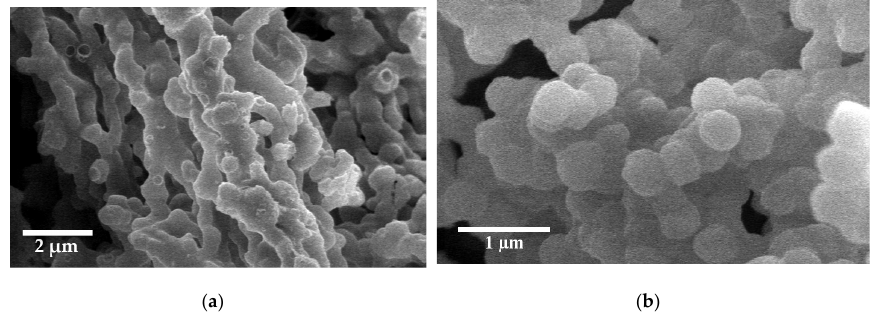
Figure 5. Scanning electron microscopy micrographs of: ( a ) E-SBA-S; ( b ) Ti-E-SBA-S materials.